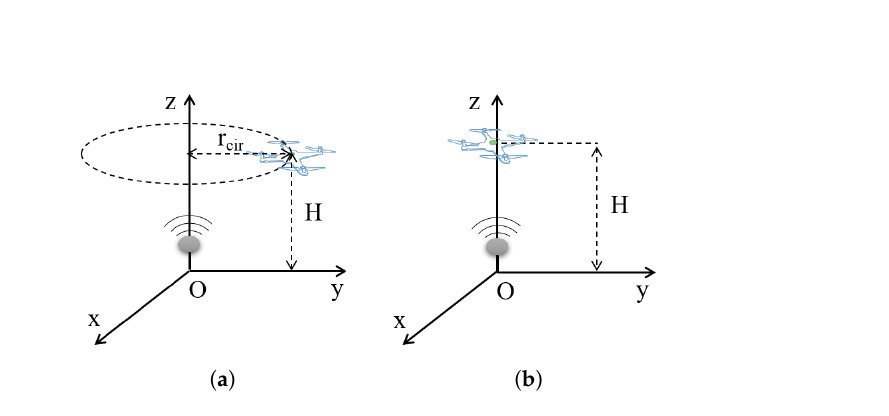
Figure 6. Two flight trajectories are comparied in the UAV-assisted wireless communication network. The vertical distance between the IoT user and the UAV is H . ( a ) The circular flight. ( b ) The hover flight.